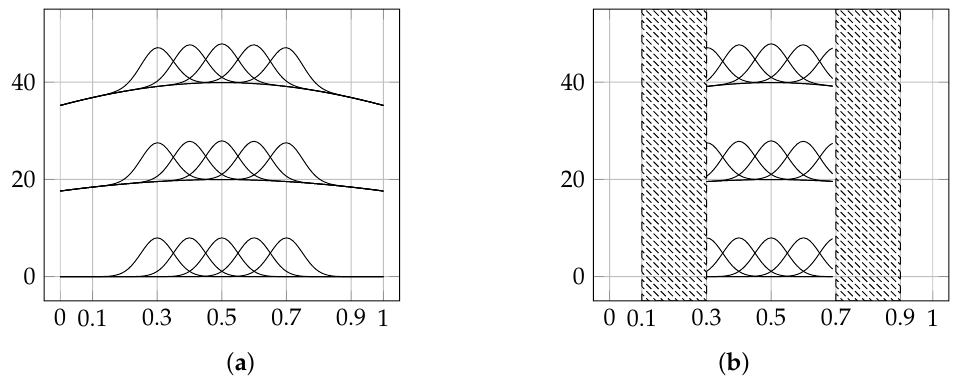
Figure 7. Comparison of available data for full model data and incomplete model data. ( a ) Full model data snapshot set for p d = 1. ( b ) Incomplete model data snapshot set for p d = 1.